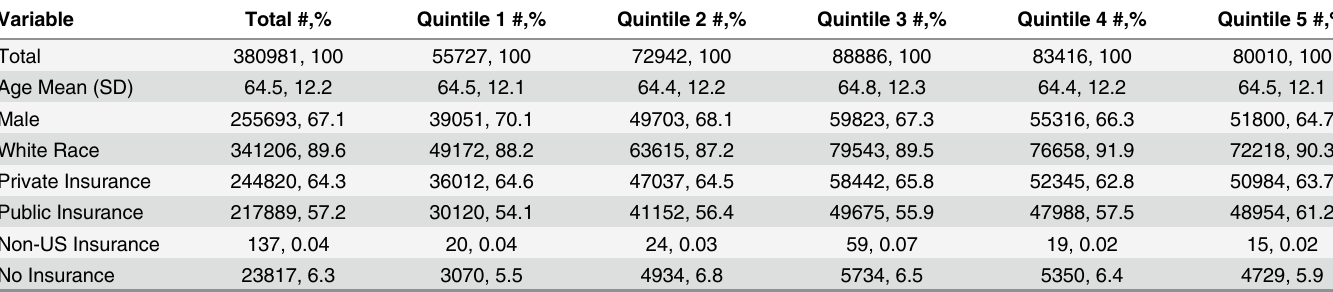
Table 2. Baseline demographic characteristics of all patients stratified by quintile of PCI